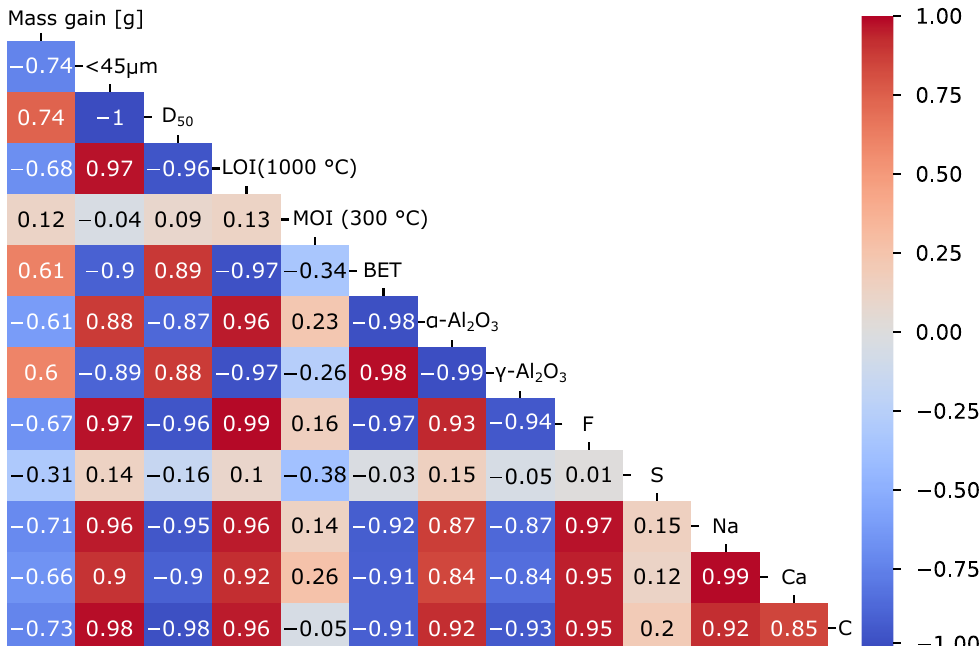
Figure 5 states the correlation coefficients between the mass gain at 60 s holding time and selected parameters. Correlation between other parameters are also shown in the same figures.